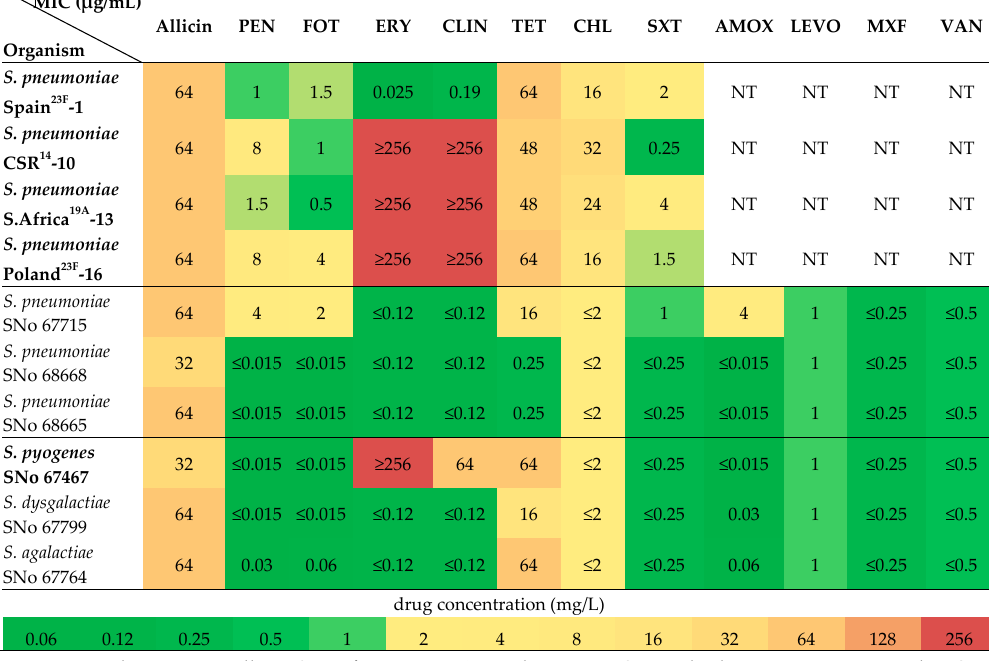
Table 1. Minimal inhibitory concentration (MIC) and minimal bactericidal concentration (MBC) in µg/mL for allicin. The MICs and MBCs were determined following EUCAST (European Committee on Antimicrobial Susceptibility Testing) guidelines. MDR strains are shown in bold.